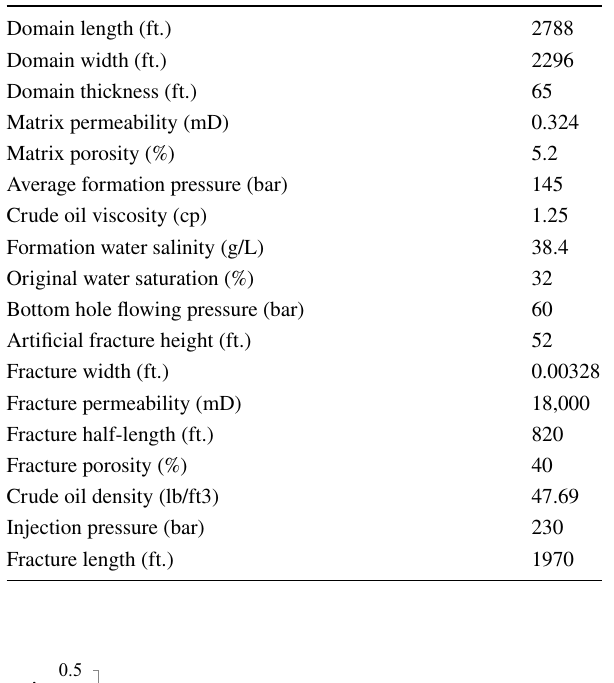
Table 1 Input parameters for CMG simulator Domain length (ft.)